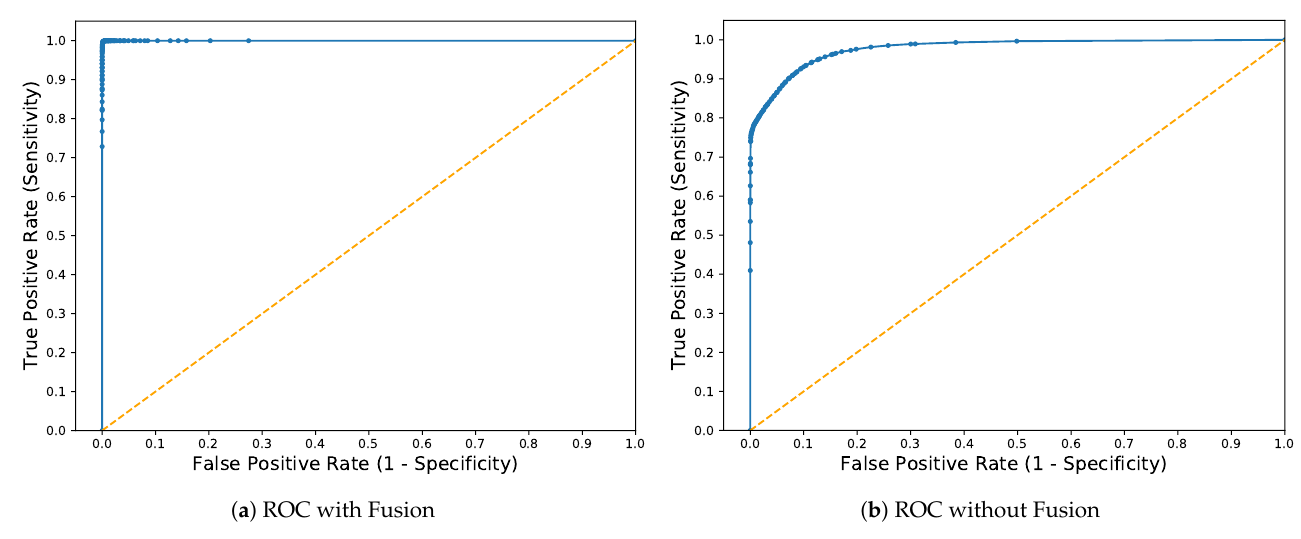
Figure 4. Receiver Operation Characteristics (ROC) Curve with and without